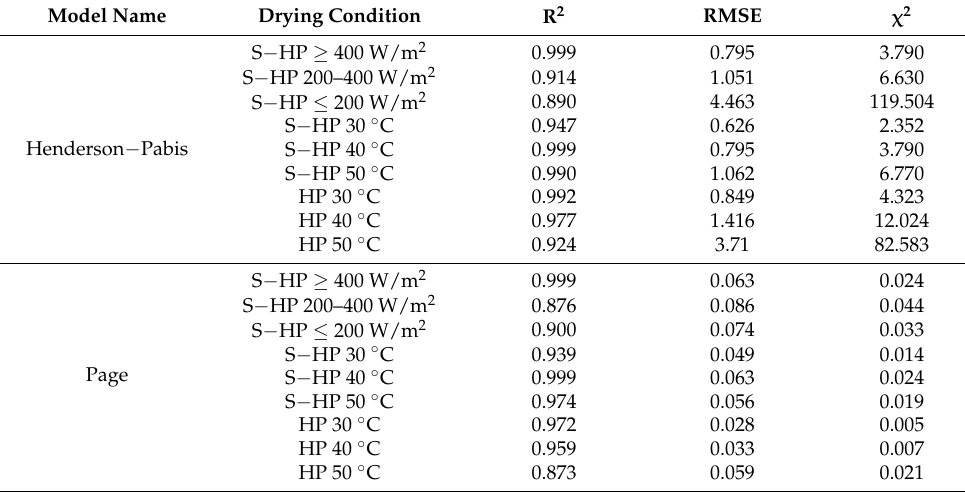
Table 5. Curve fitting parameters under different drying